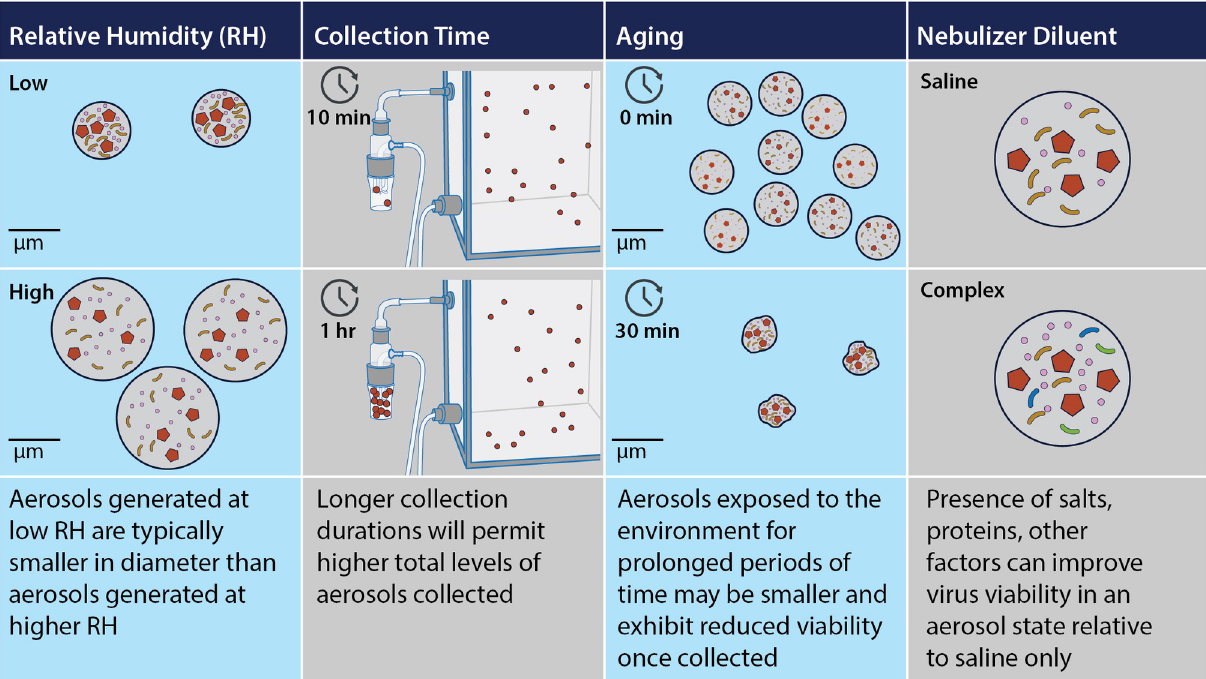
Fig 1. Examples of protocol-specific parameters that can modulate properties of aerosols generated in the laboratory. Columns depict some of the specific variables that may be controlled for and manipulated in laboratory settings. Within particles, red pentagons depict virus being aerosolized, circles and rods depict salts and proteins, respectively, with rods of different colors depicting a greater diversity of proteins within more physiologically relevant diluent suspensions. Scale bars and time intervals are for representative purposes only. The parameters presented here can influence each other (e.g., aging aerosols at different humidities may differentially alter particle size), and summary statements represent one of several potential outcomes from modulating these (and other) experimental conditions.